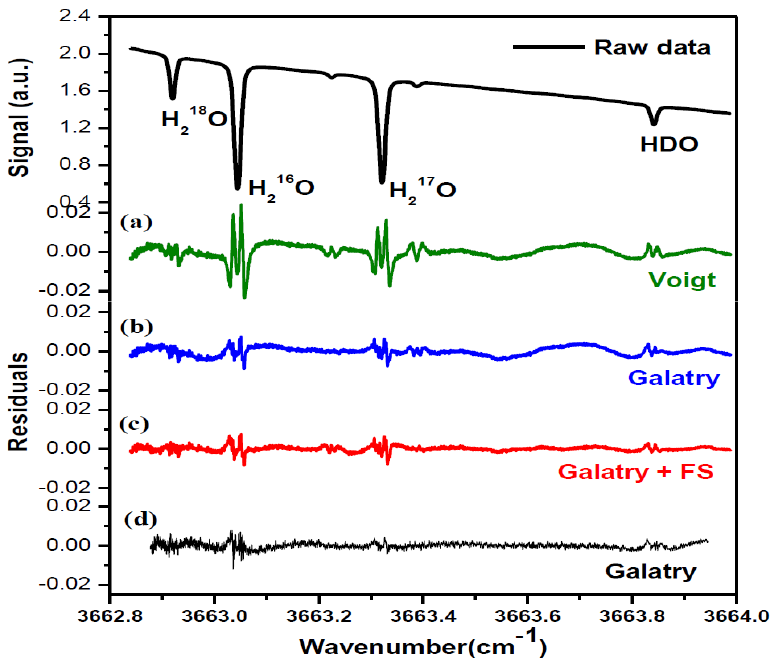
Figure 3. H O isotopologue absorption spectrum measured in this work (raw data). 2 Spectral data were fitted to Voigt and Galatry profiles. Residuals resulting from each fit are shown: ( a ) from Voigt fit and ( b ) from Galatry fit, respectively. ( c ) shows the fit results using Galatry profiles in combination with a Fourier series function (FS) to remove oscillation structure from the spectrum baseline. ( d ) shows a fit residual from a spectrum in the absence of an undulating structure on the